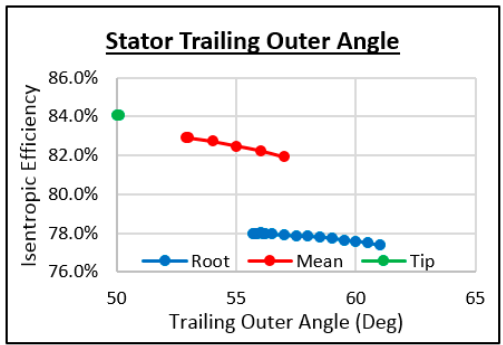
Figure 27. Study of the stator trailing outer angle.